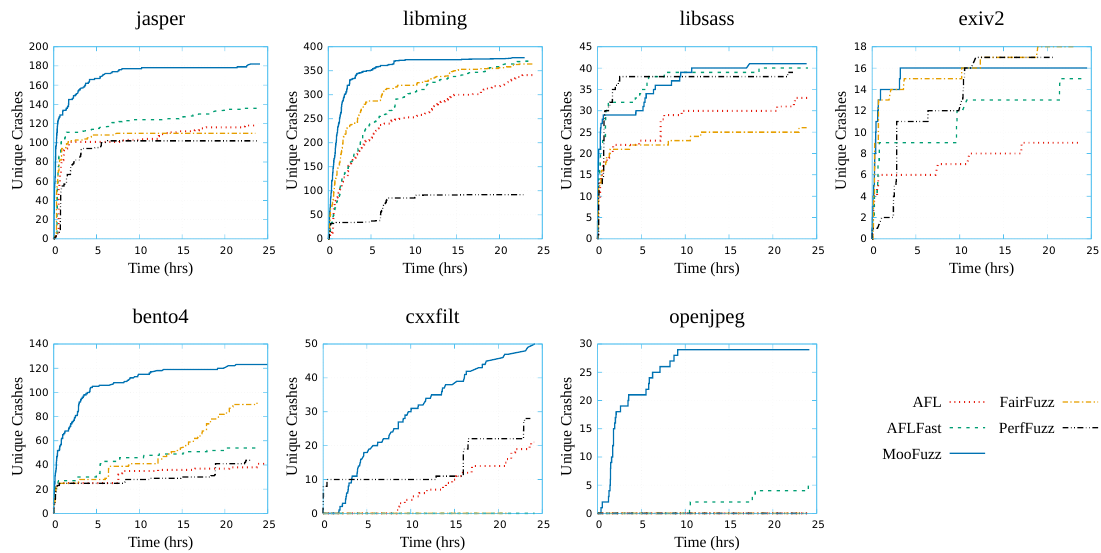
Figure 3. The growth trends of unique crashes discovery in different fuzzers within 24 h. First, different fuzzers have different capability in fuzzing different application pro- grams. For example, PerfFuzz has zero crash in fuzzing openjpeg within 24 h, but it